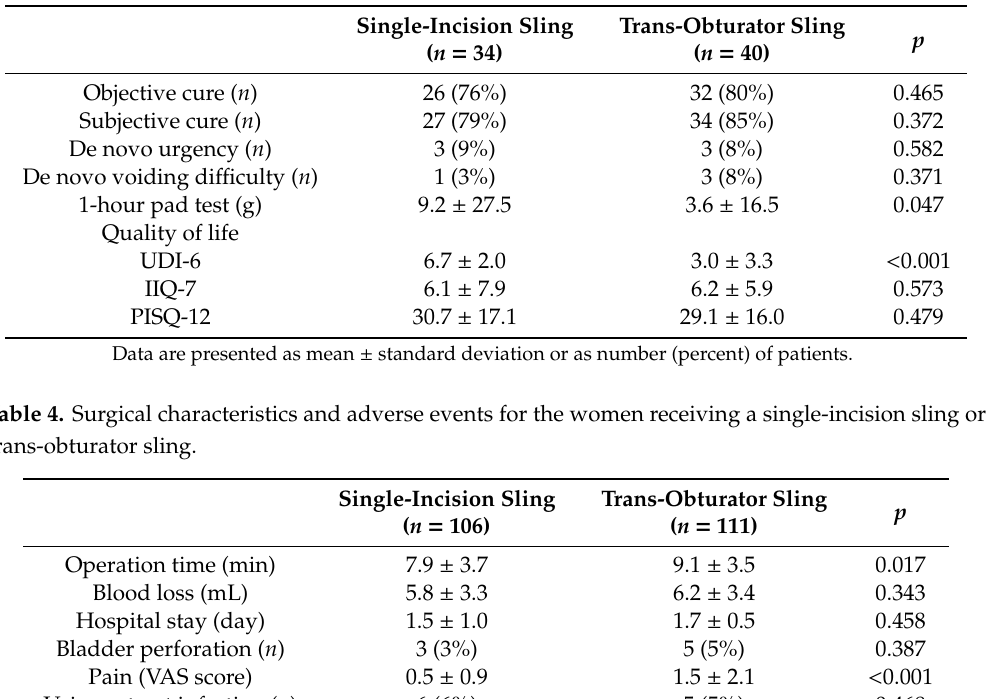
Table 3. Outcomes of the women with obesity (BMI ≥ 30 kg / m 2 ) after receiving a single-incision sling or trans-obturator sling.